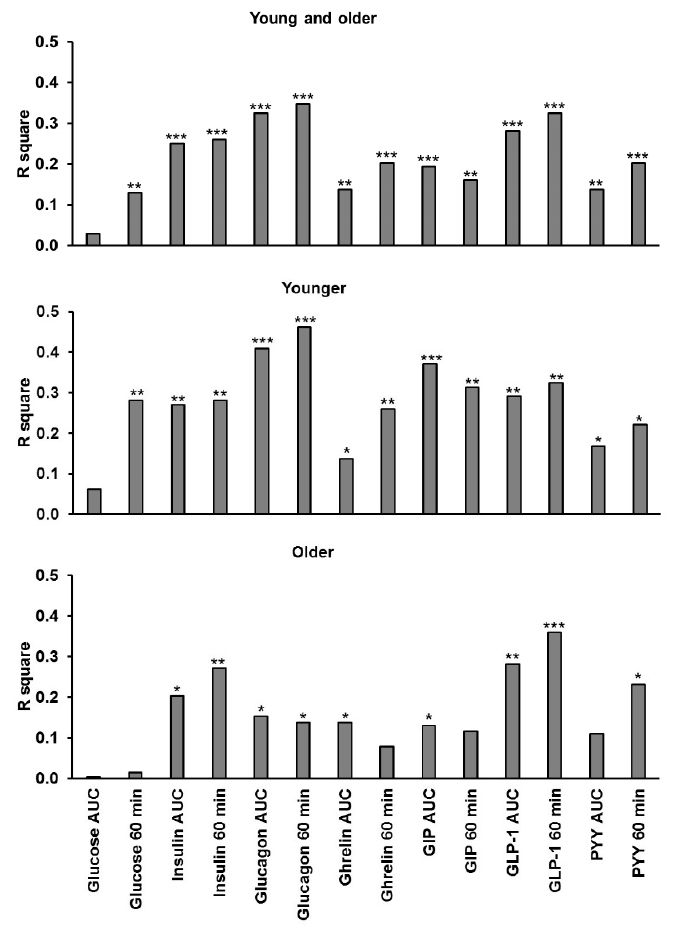
Figure A1. Within-subject relationships between energy intake (results of suppression of ad libitum energy intake after the intraduodenally infused whey protein loads have been published previously [31]) and area under the curve (AUC 0–60 min) of glucose, insulin, glucagon, ghrelin, GIP, GLP-1, and PYY concentrations in healthy older and younger men combined ( n = 20; n = 19 for GIP and GLP-1), younger men ( n = 10; n = 9 for GIP and GLP-1), and older men ( n = 10). Within subject correlations were determined using a general linear model with fixed slope and random intercept. Statistical significance was accepted at p < 0.05. * p < 0.05, ** p < 0.005, *** p <